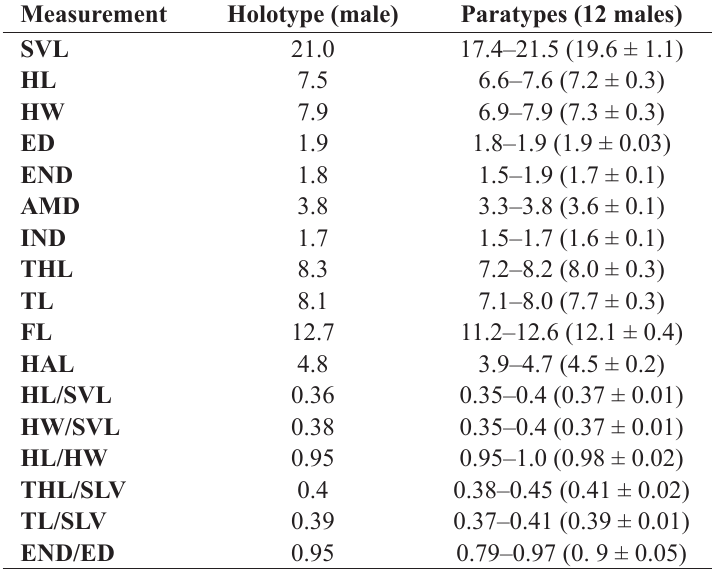
Table 1. Morphometric measurements (in mm) and proportions of the Physalaemus araxa sp. nov. type series. Values are presented as range (average ± SD). See Material and methods for